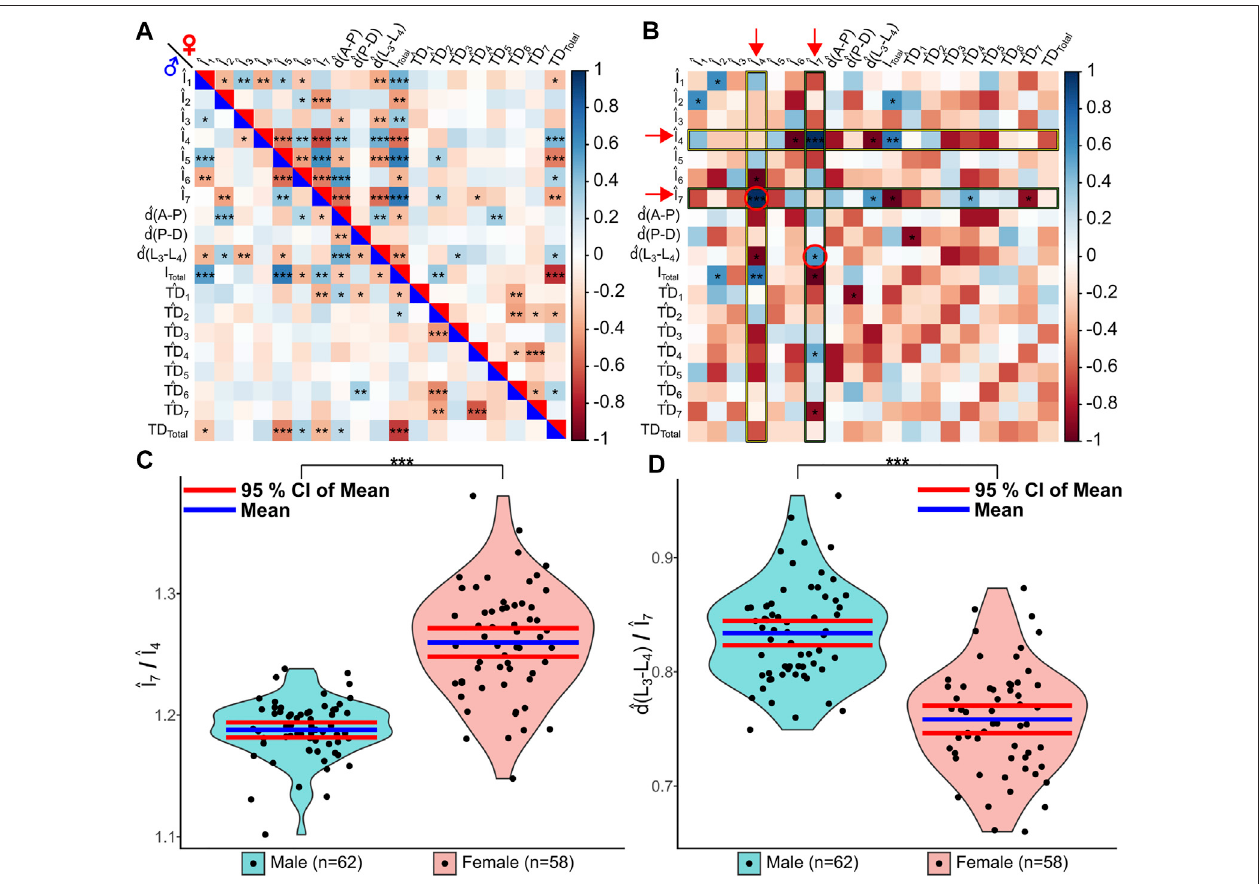
FIGURE 6 | MAPPER identi fi es unique scaling relationships between wing populations. MAPPER output data of male and female Samarkand strain wings (Sonnenschein et al., 2015) were analyzed to identify potential scaling relationships between features. All geometric features were normalized to become unitless features, denoted by the hat symbol. (A) A correlation plot of the features for males (lower-left triangle) and females (upper-right triangle) is shown. Signi fi cance of correlation is denoted by asterisks with p < 0.05 *, p < 0.01 **, and p < 0.001 ***. (B) Fisher ’ s Z-transformation (Fisher, 1915; Fisher, 1921) was performed on the correlation coef fi cients to observe differences in underlying correlations between the two populations. Signi fi cance of correlation is denoted by asterisks with p < 0.05 *, p < 0.01 **, and p < 0.001 ***. Z-scores were scaled to be between -1 and 1 for plot simplicity. Red arrows indicate signi fi cant correlations plotted as violin plots on subsequent fi gure panels. (C,D) The underlying correlation differences between Î 7 and Î 4 (C) and between ^ d (L 3 -L 4 ) and Î 7 (D) were found to be signi fi cant by Fisher ’ s Z-transformation between populations. Statistical tests were performed using the Mann-Whitney U Test (Mann and Whitney, 1947; Nachar, 2008) for nonparametric comparisons ( p < 0.001